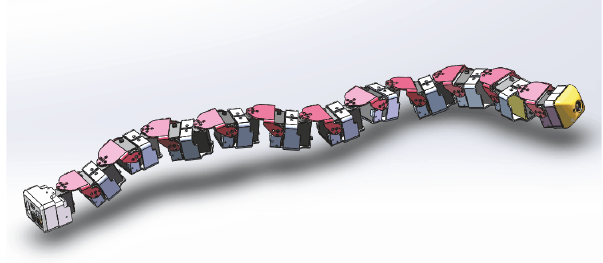
Figure 2: Assembly diagram of the snake-like robot.